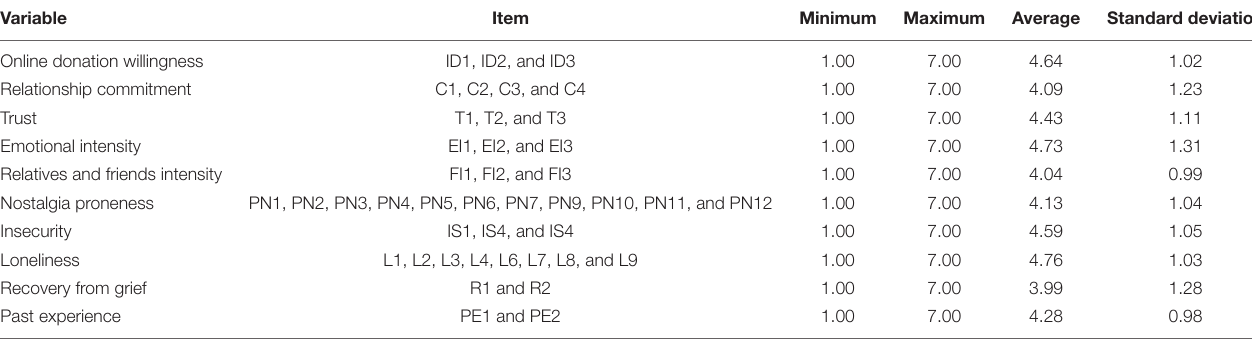
FIGURE 1 | Online donation intention model. TABLE 1 | Descriptive statistics of